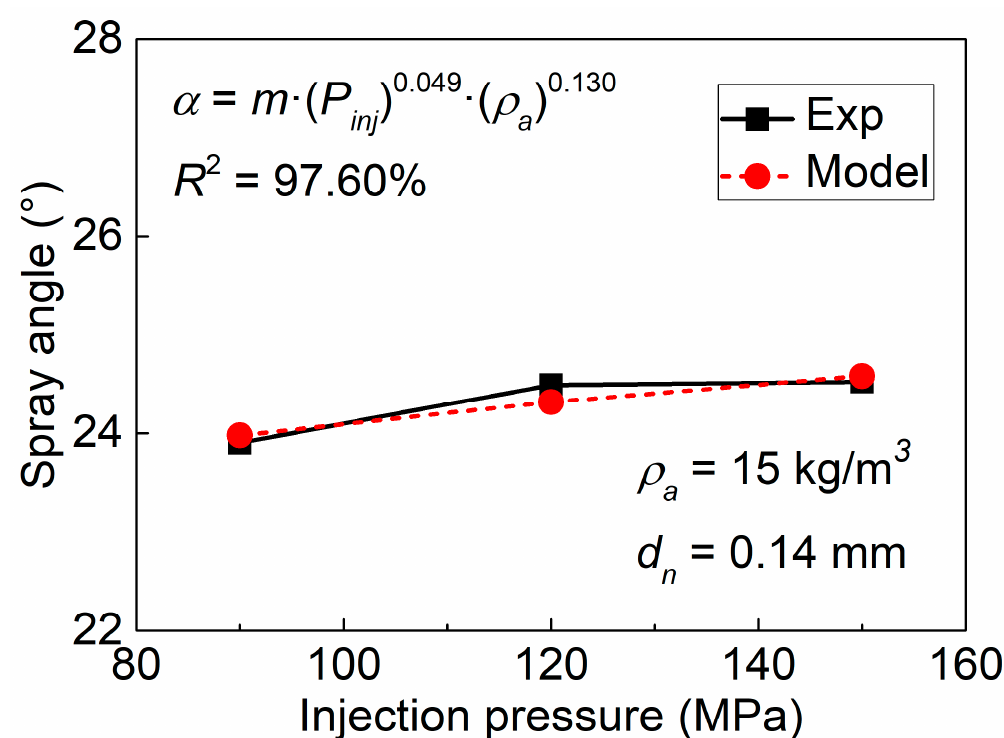
Figure 17. The experimental and predicted results for the spray angle when applying the pilot-main injection strategy under various injection pressures.